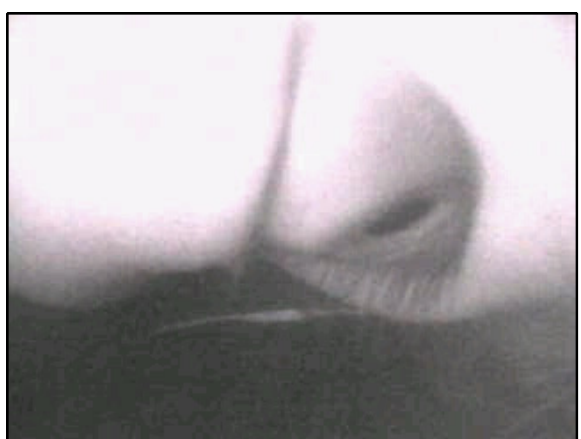
Figure 53. Too many dark pixels in the eye socket.